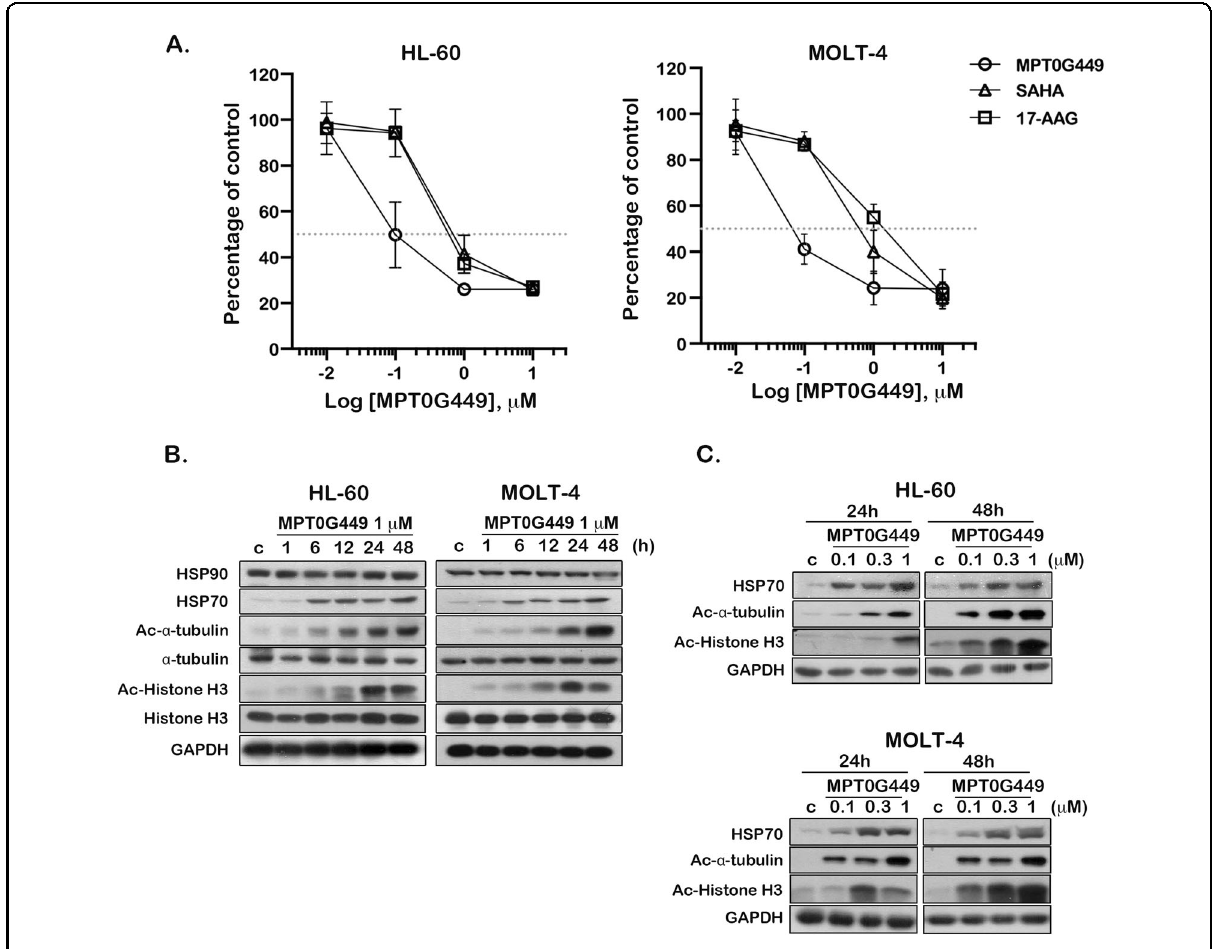
Fig. 2 MPT0G449 induces cytotoxicity and inhibits HDAC/HSP90 enzyme activity in acute leukemia cell lines. A Cell viability was measured in acute leukemia cell lines, HL-60 and MOLT-4, after 48 h of incubation with MPT0G449, SAHA and 17-AAG (0.01, 0.1, 1, 10 μ M), respectively. The results represent the mean ± SD of three independent experiments. B , C The effect of protein acetylation and HSP70 expression in HL-60 and MOLT-4 cells. Cells were cultured with DMSO (control; c) or indicated concentrations of MPT0G449 for 1, 6, 12, 24, and 48 hours. Whole-cell lysates were detected by western blotting. The data were repeated for at least three independent